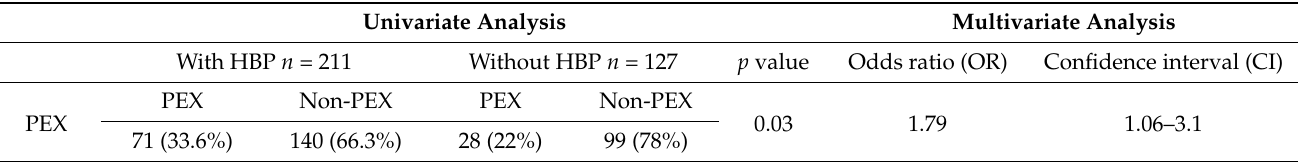
Table 4. Analysis of the relationship of PEX with